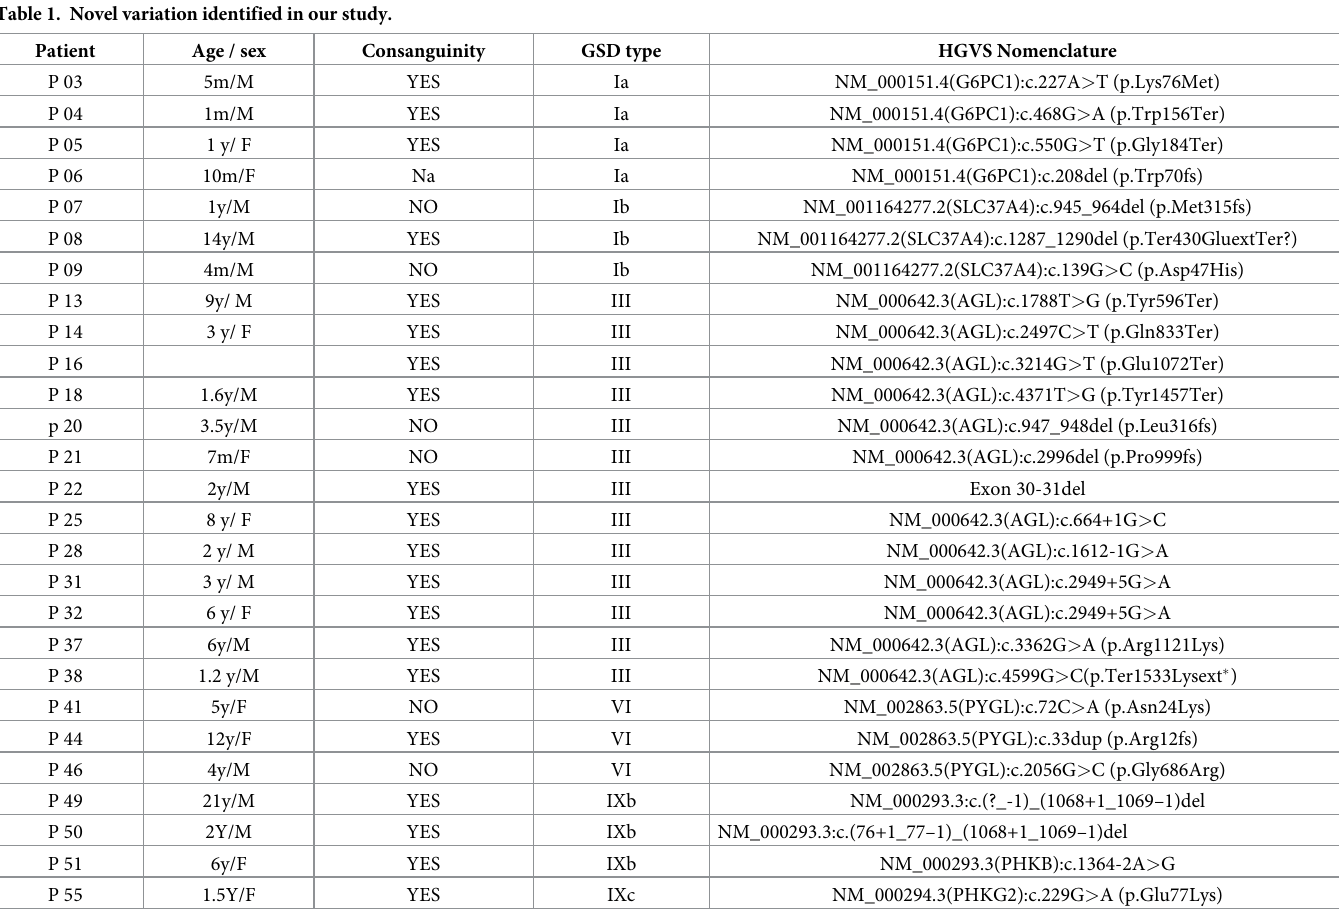
Table 1. Novel variation identified in our